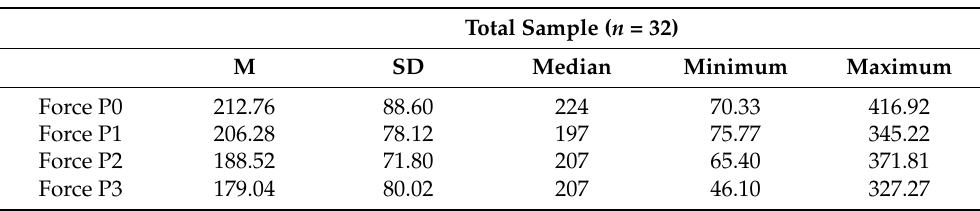
Table 4. Means (M), standard deviations (SD), minimums, and maximums for the total sample forces of the volunteers from ISEC.